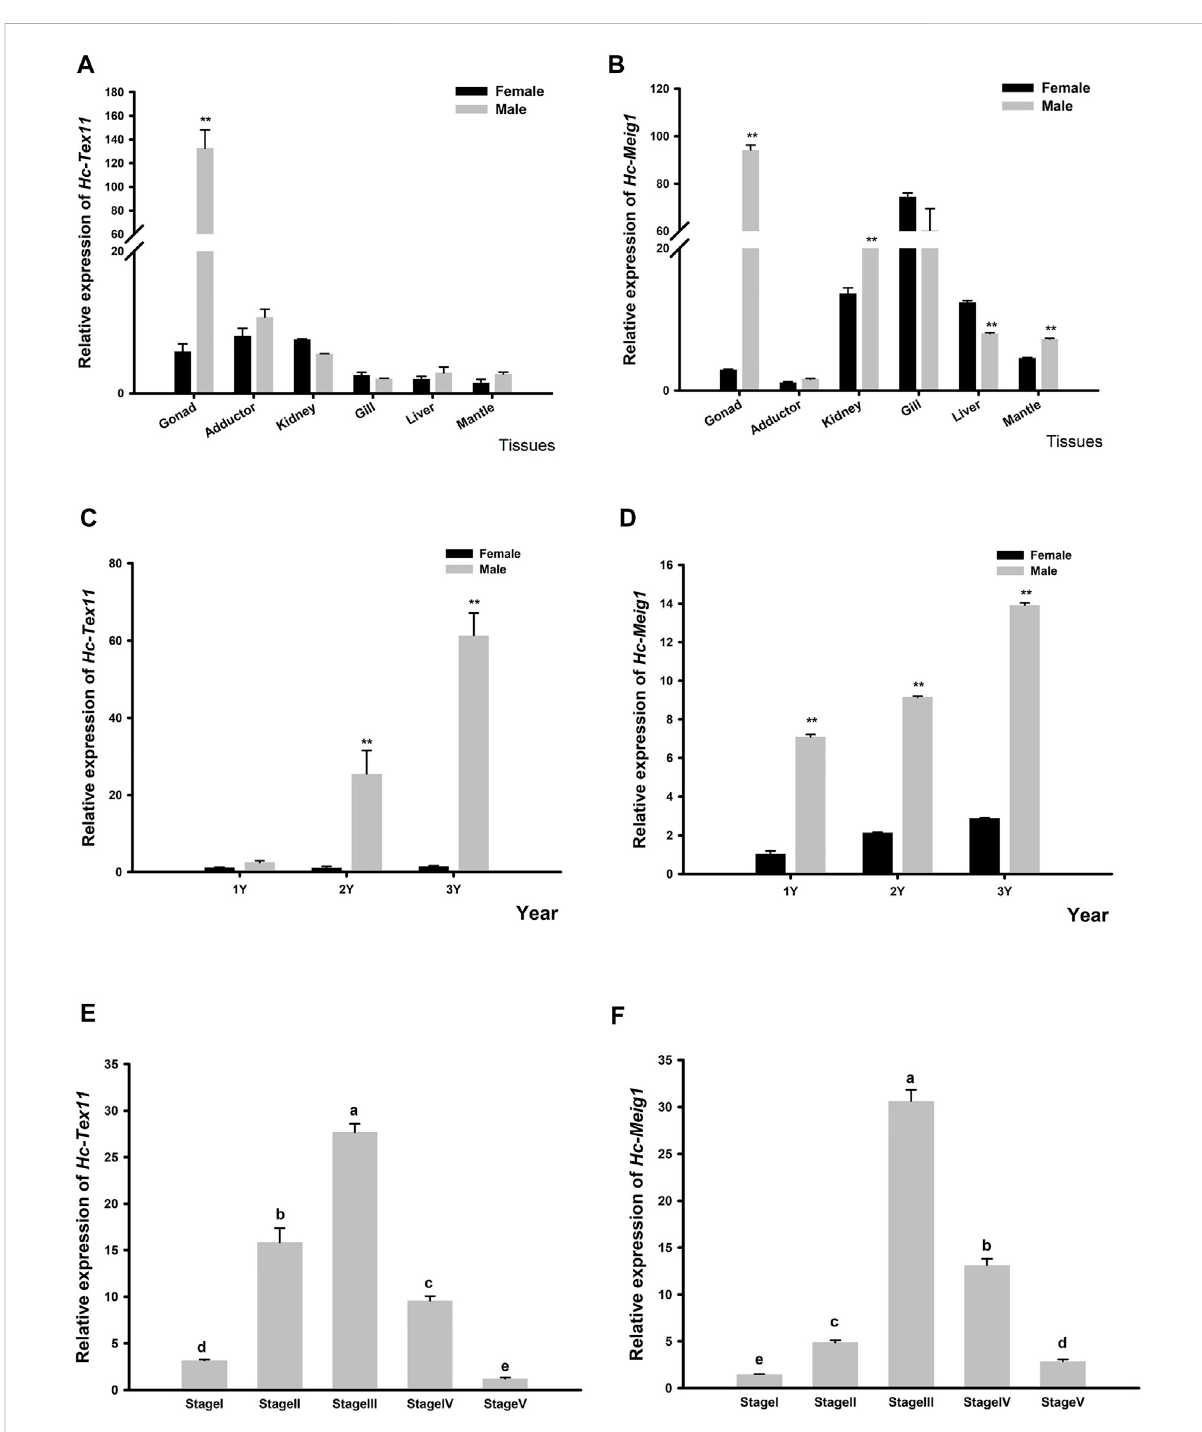
FIGURE 7 (A) Relative expression of Hc-Tex11 gene in male and female tissue (B) Relative expression of Hc-Meig1 gene in male and female tissue (C) Relative expression of the Hc-Tex11 gene in 1-3-year-old male and female gonads (D) Relative expression of the Hc-Meig1 gene in 1-3-year-old male and female gonads. Signi fi cant differences, * indicates p < 0.05, ** indicates p < 0.01 (E) Relative expression of Hc-Tex11 gene during spermatogenesis (F) Relative expression of Hc-Meig1 gene during spermatogenesis. Results are expressed as mean ± SD, and different letters (A – E) indicate statistically signi fi cant differences ( p < 0.05). Stage1, spermatogonia stage; stage2, spermatocyte stage; stage3, sperm maturation stage; stage4, sperm discharge period; stage5, follicular atrophy